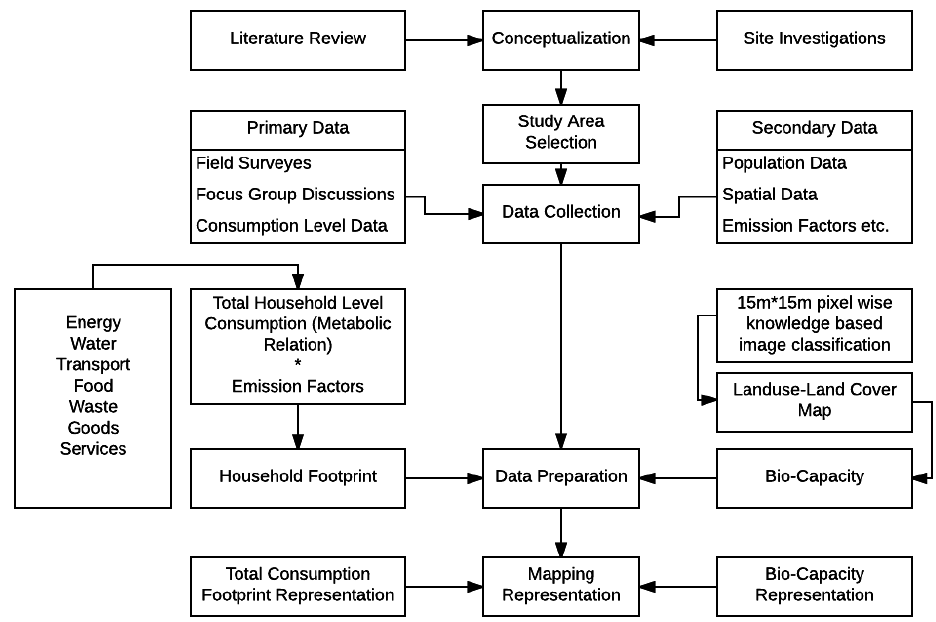
Figure 2. Schematic Diagram of Methodological Approaches.